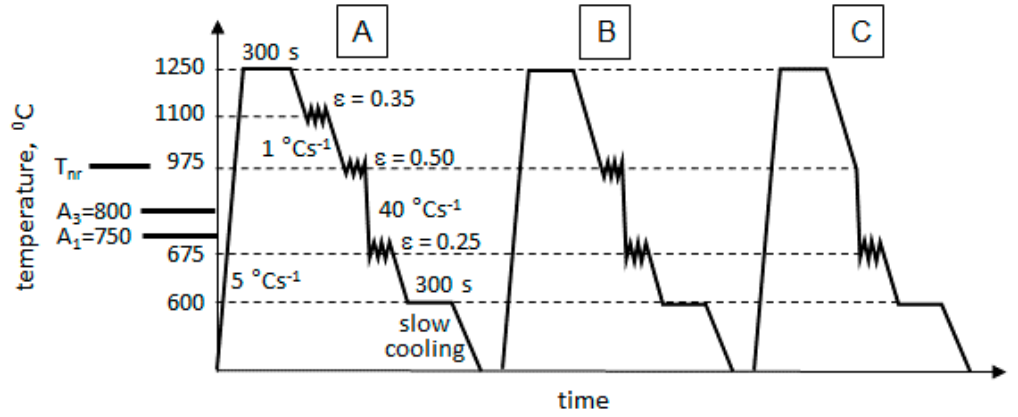
Figure 1. Schemes of processing schedules investigated: ( A ) with two deformations, ( B ) one deformation, or ( C ) no deformation in austenite temperature region.